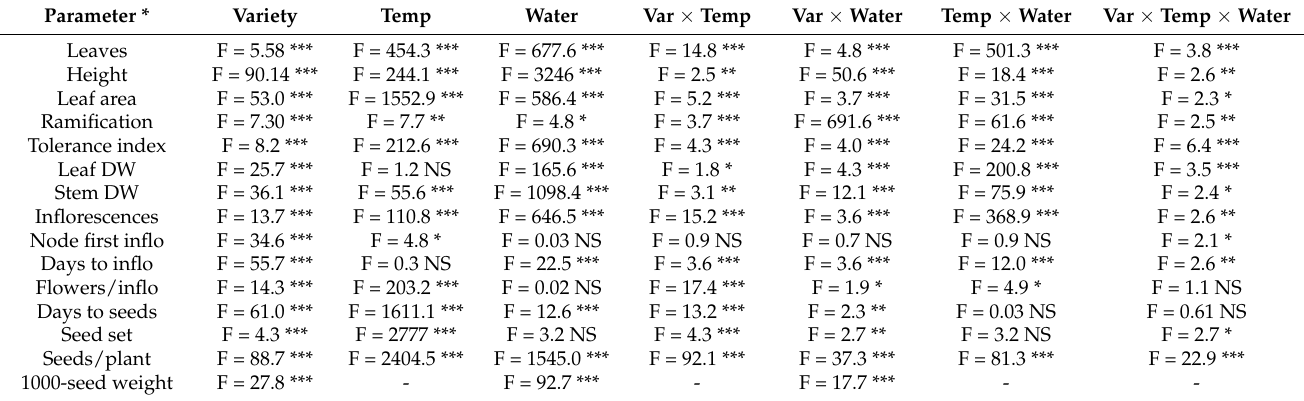
Table 1. Statistical results (ANOVA3) of vegetative and reproductive parameters of F. tataricum varieties subjected to two temperatures (21 ◦ C vs. 28 ◦ C) and water supply conditions (well-watered (WW) vs. water-stressed (WS)).